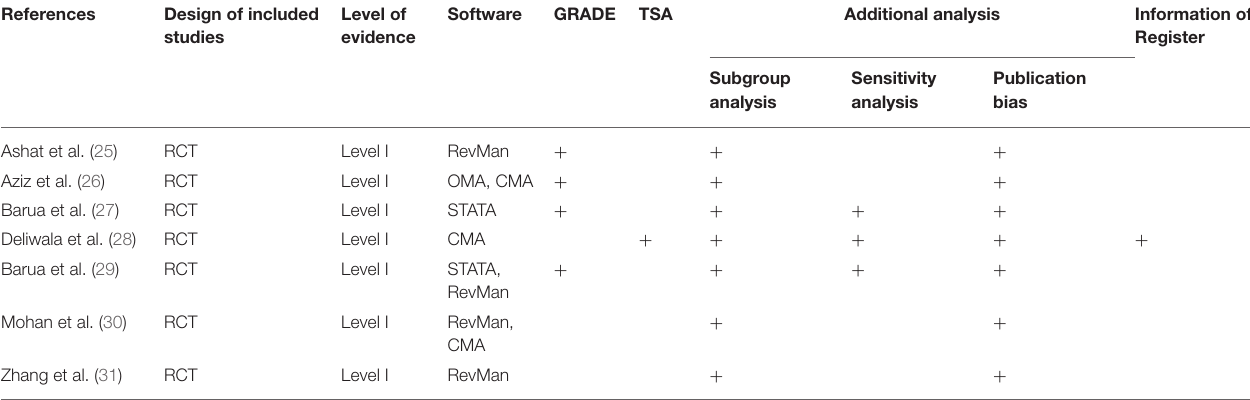
TABLE 4 | Methodology for each meta-analysis.